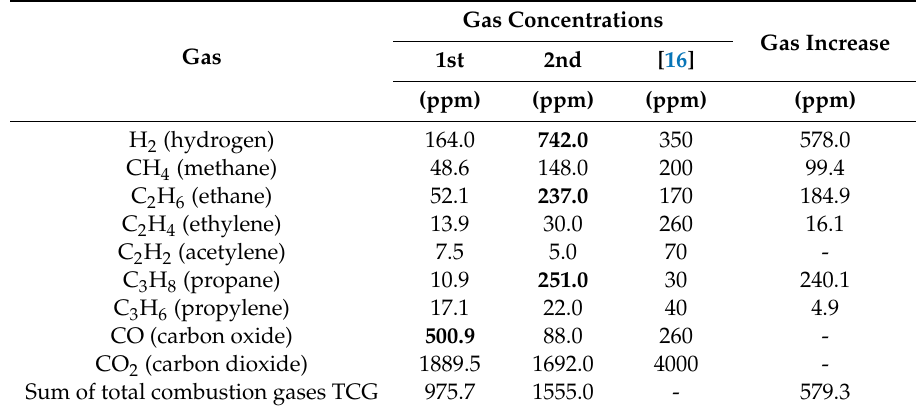
Table 7. Gas concentrations measured for oil samples taken from a 30 MVA, 110 / 10.5 kV power transformer (exceedance of the typical values is marked in bold